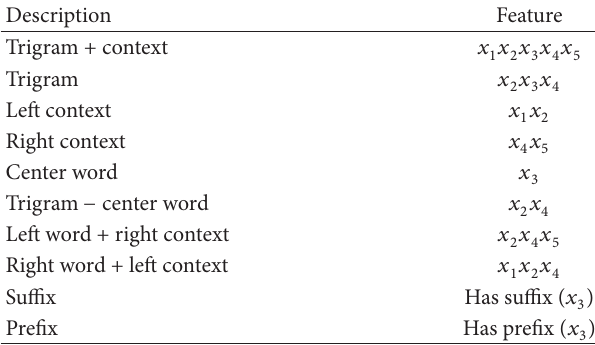
Table 1: Various features for computing edge weights between Chinese trigram